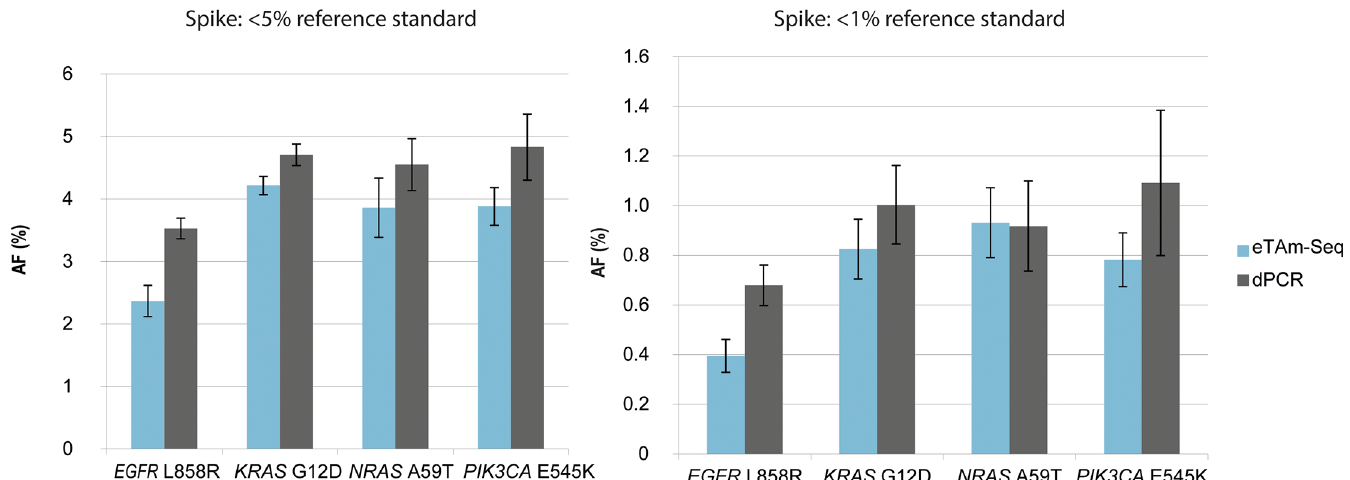
Fig 4. Quantitative agreement of 5% AF and 1% AF reference standard spiked into plasma, and measured by eTAm-Seq technology and dPCR. Mean mutant AF (%) ± SD are displayed for each technology (n = 5 (cid:3) (5% AF standard); n = 6 (1% AF standard)). By spiking into plasma containing background wild-type DNA, the resulting mix was confirmed to contain lower AFs than the original reference standards (original mutant AF values 5% standard: 5% ( EGFR );6.3% ( KRAS , NRAS , PIK3CA );1% standard: 1% ( EGFR ),1.3% ( KRAS , NRAS , PIK3CA ).( (cid:3) 1 data point omitted due to anomalous extraction